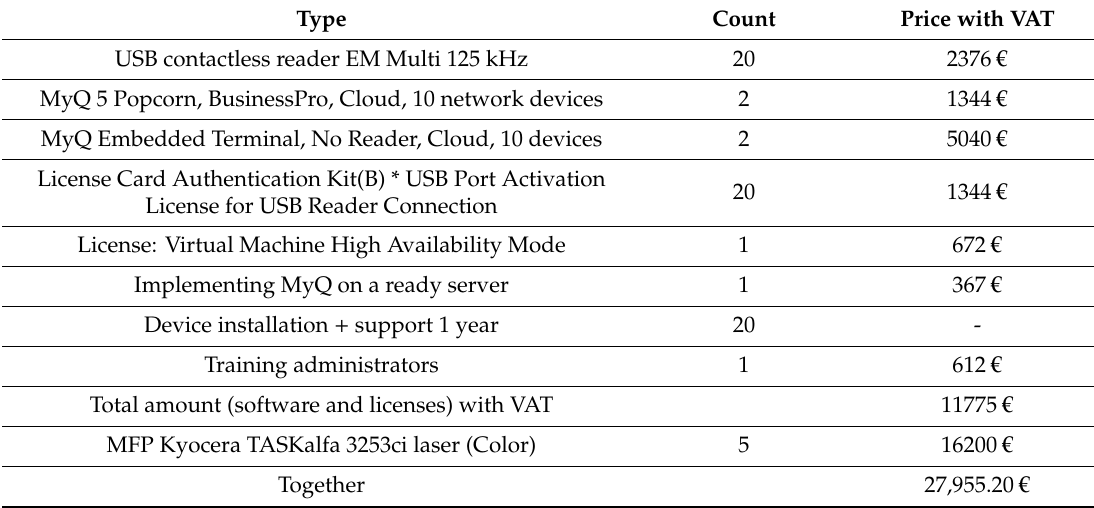
Table 6. Price calculation of printing solution for the